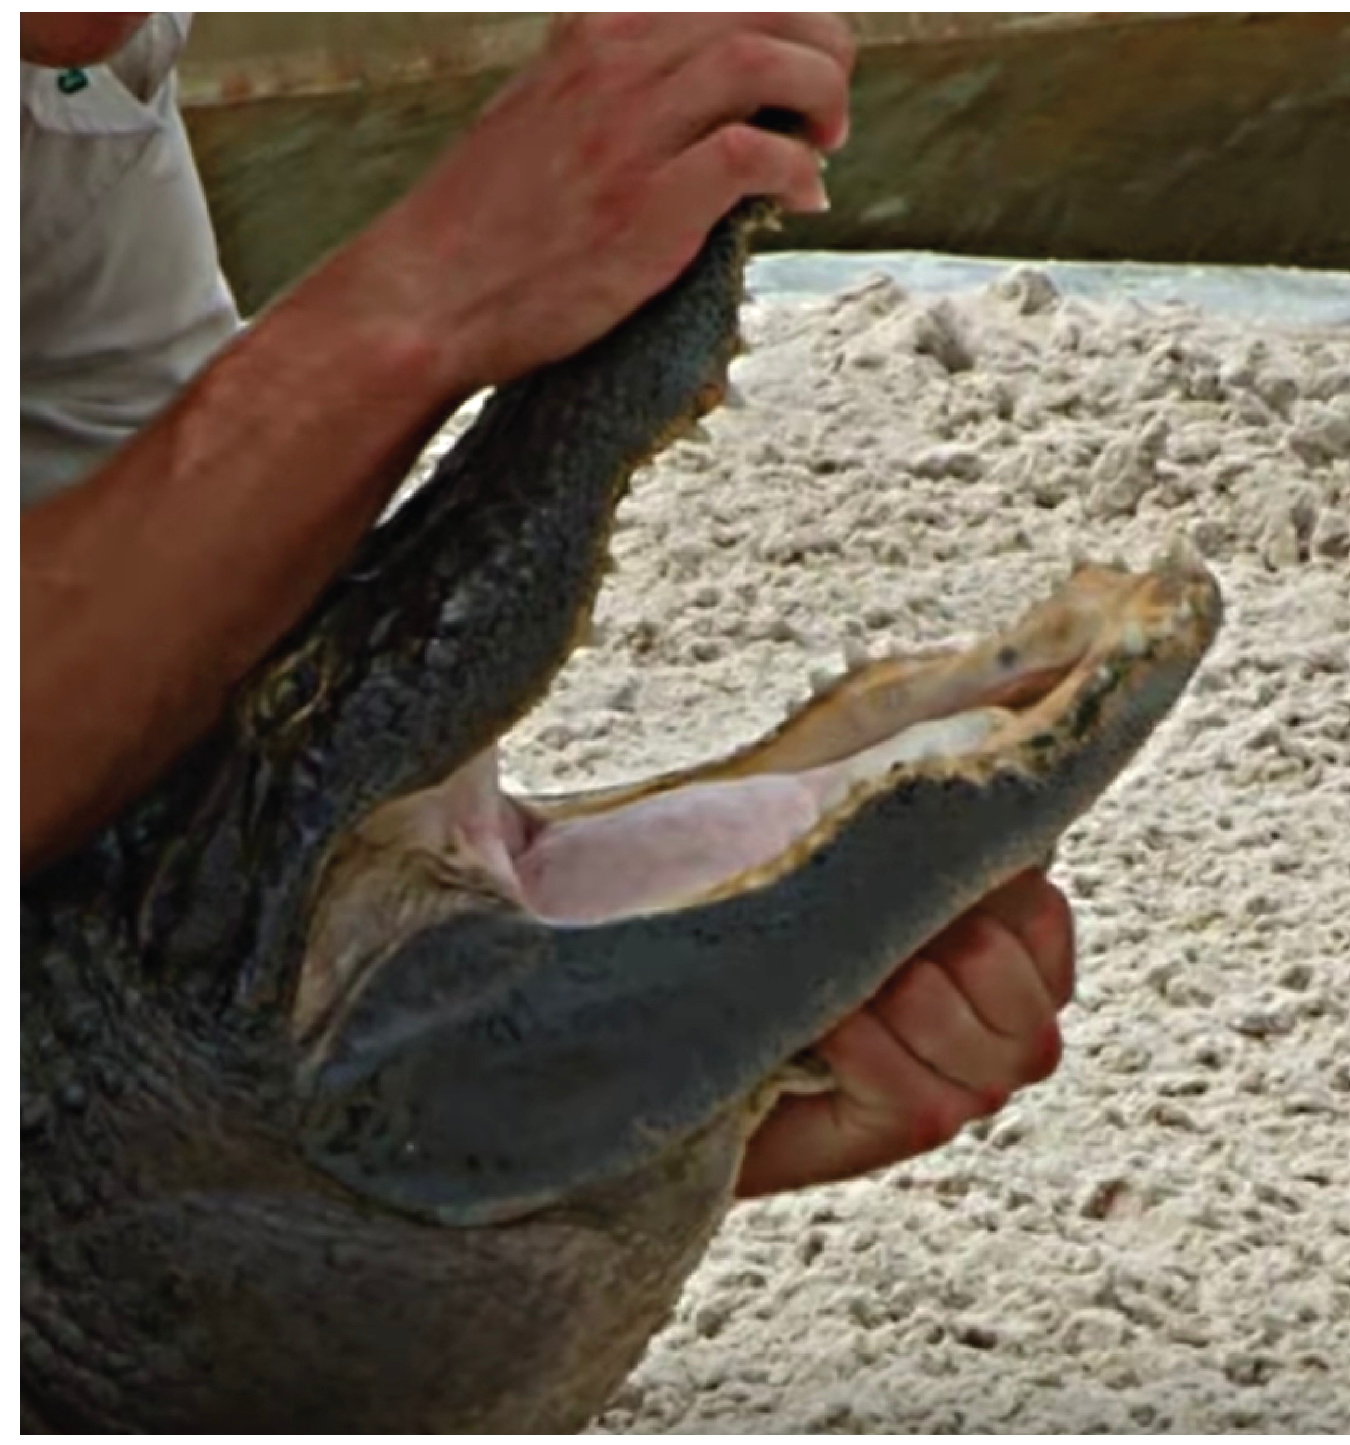
Fig 1. The “Florida Smile” stunt. Image captured from a video in the dataset.